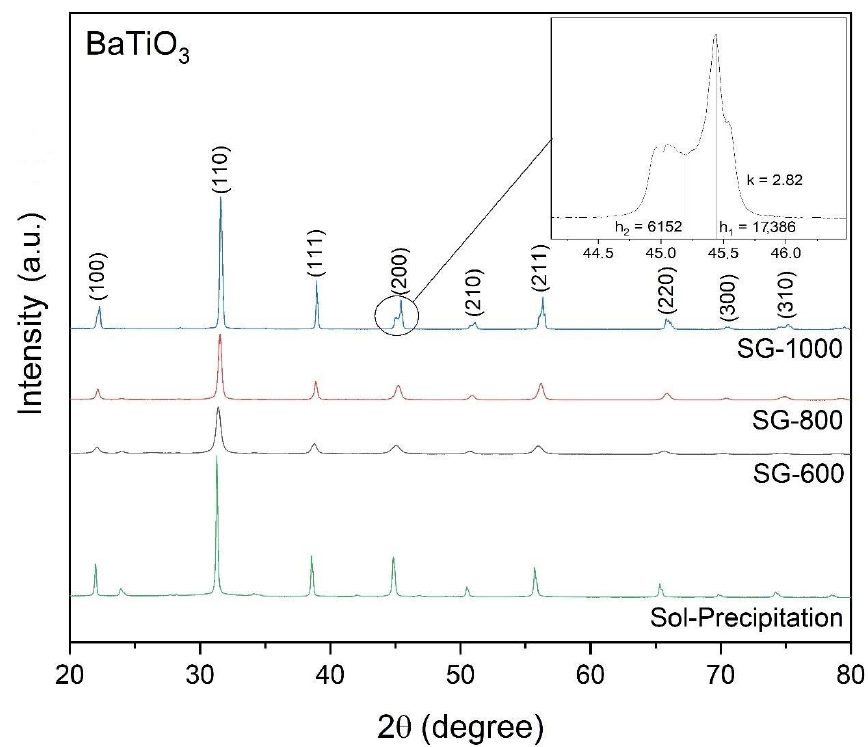
Figure 4. Diffraction pattern of the powders obtained by the sol-gel method, heat-treated at different temperatures (600 ◦ C, 800 ◦ C and 1000 ◦ C) and synthesized via the sol-precipitation method. The detail shows the peak intensity for the plane (200) and the depression of the plane (002) of the sample calcined at 1000 ◦